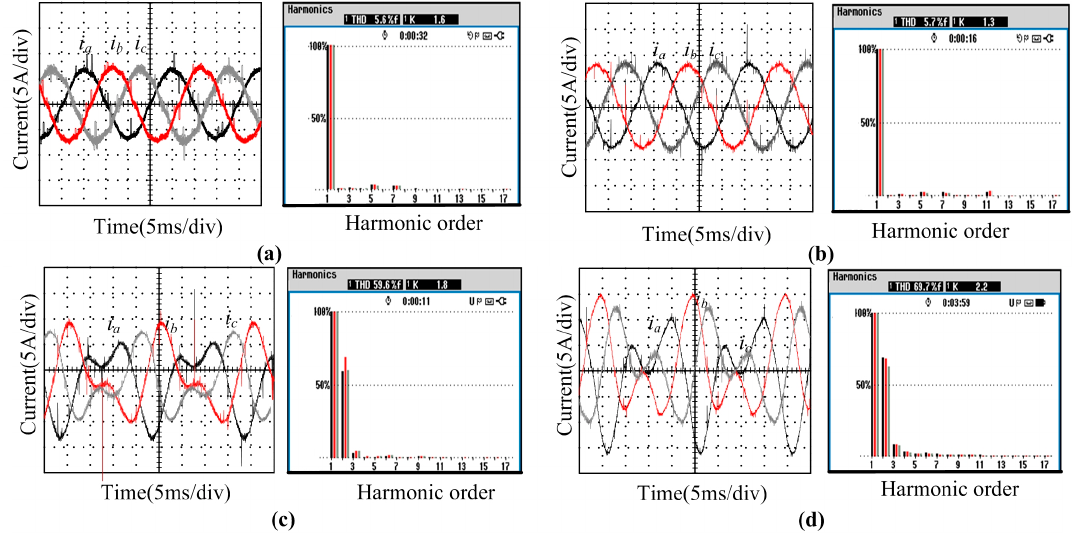
Figure 18. Grid-connected currents comparison under different current sampling schemes with varied grid impedance. ( a ) Grid-connected currents under IC sampling with L g = 4 mH; ( b ) Grid-connected currents under GC sampling with L g = 4 mH; ( c ) Grid-connected currents under IC sampling with L g = 6 mH; ( d ) Grid-connected currents under GC sampling with L g = 6 mH.